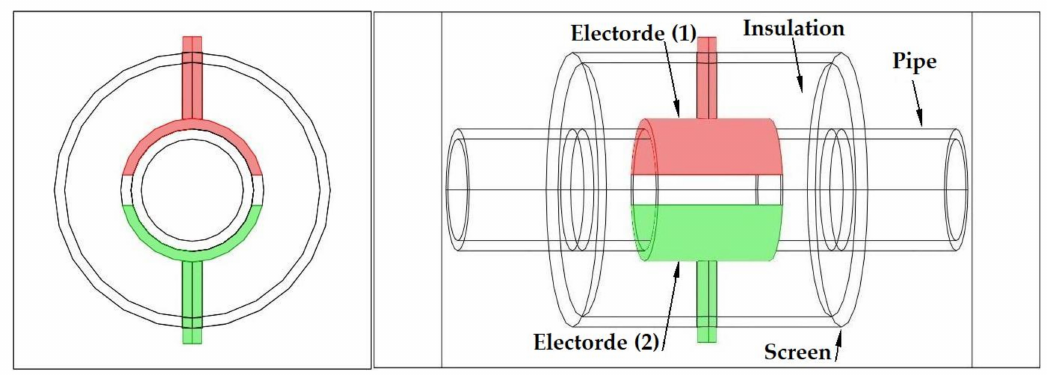
Figure 3. The configuration of the simulated concave two-electrode sensor and the